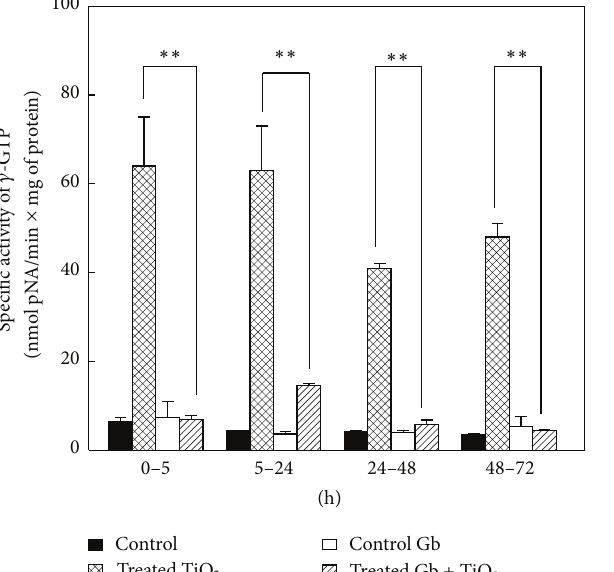
Figure 1: The effects of GbE on the renal effects of titanium dioxide (TiO 2 ) of the 𝛾 -glutamyltranspeptidase enzymatic activity in urine, at different time periods, compared with control, GbE, and TiO 2 - treated rats. The enzymatic activity is shown as nmol p-NA/min × mg of protein. The values represent mean ± SEM, 𝑛 = 6 . The significance level is ∗∗ 𝑃 < 0.01 ; pNA: p-nitroanilide.